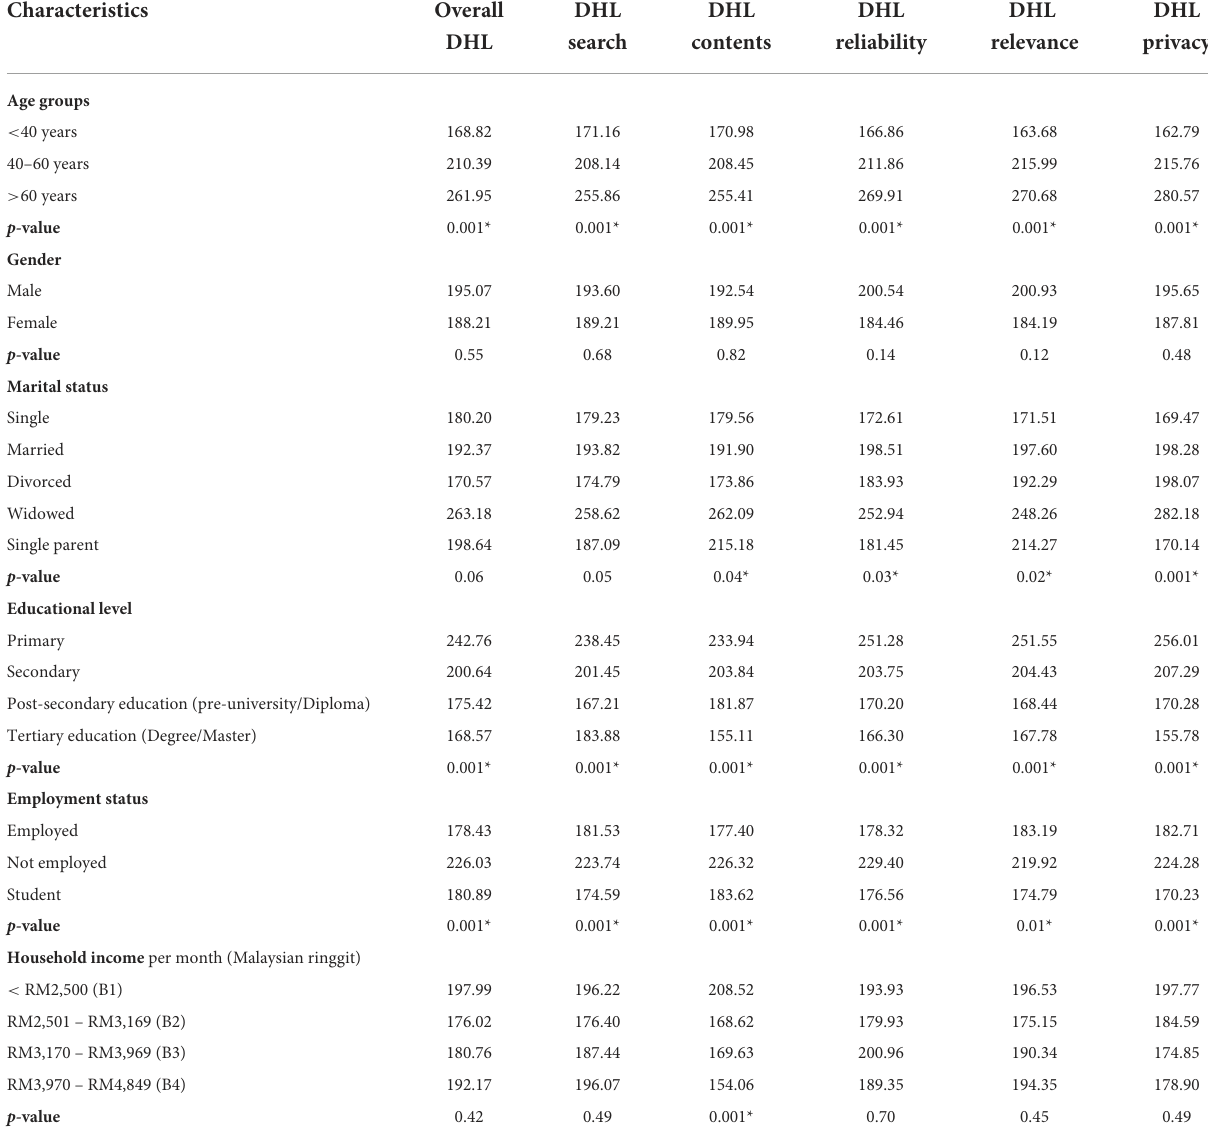
TABLE 2 Comparison of participants’ characteristics and digital health literacy ( n = 301).